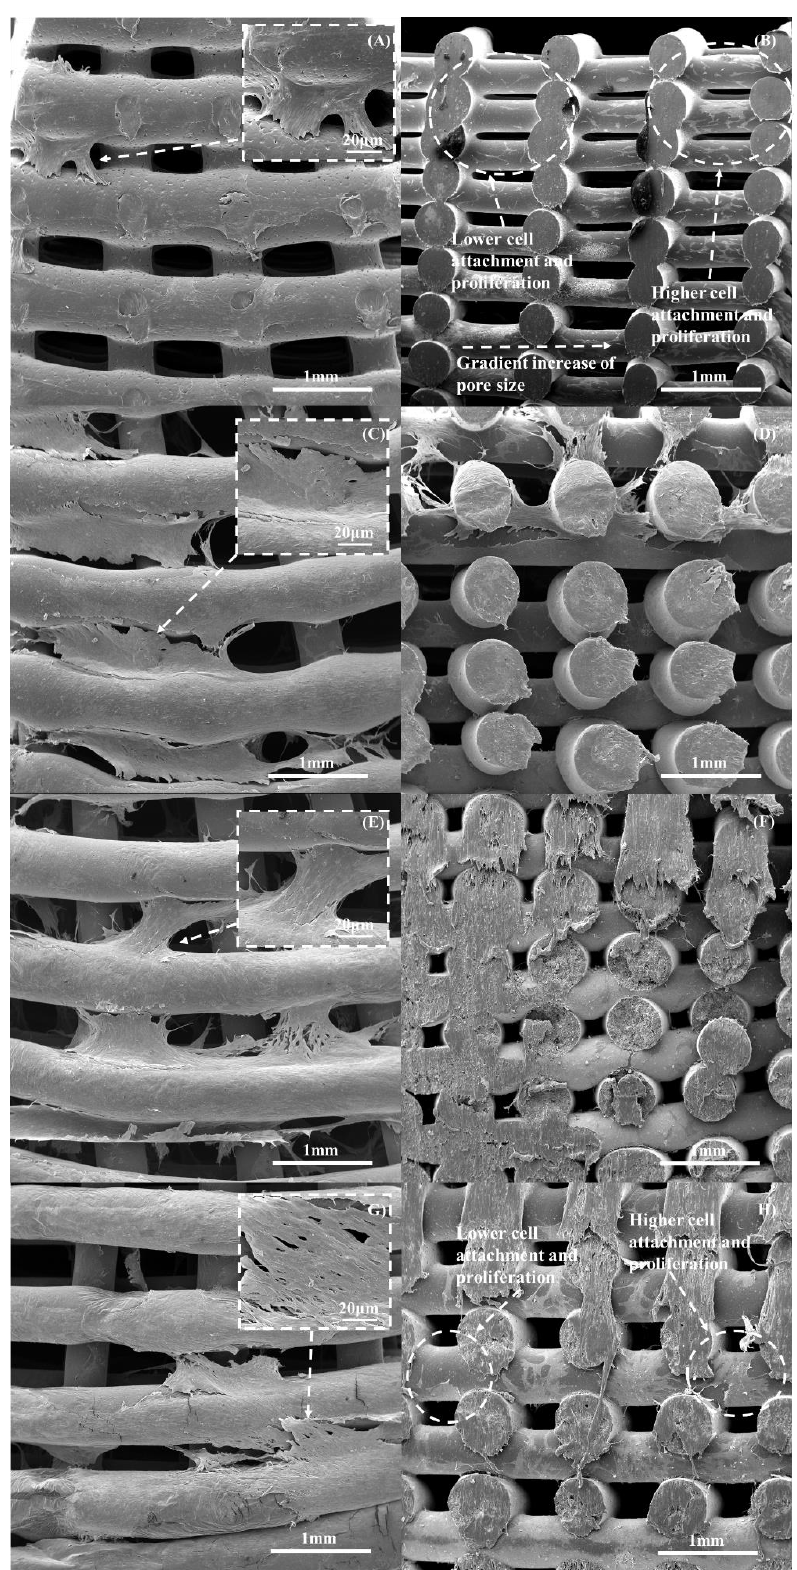
Figure 15. The top and cross-section SEM images showing cell spreading on the scaffolds with different material compositions on day 14: ( A , B ) PCL; ( C , D ) 10 wt% bioglass; ( E , F ) 15 wt% bioglass; and ( G , H ) 20 wt% bioglass.